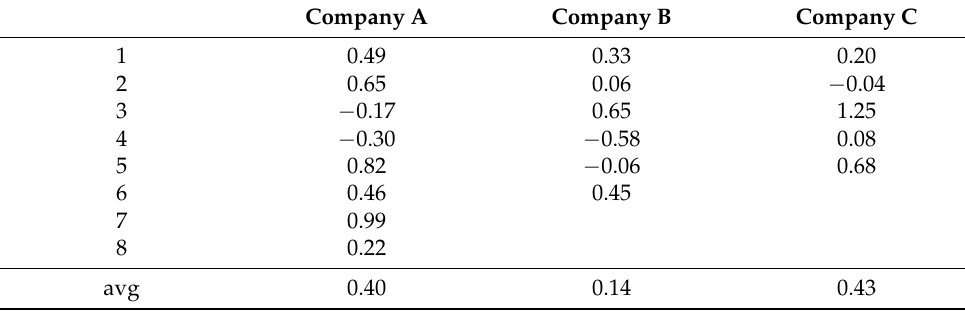
Table 1. Interview Sentiment